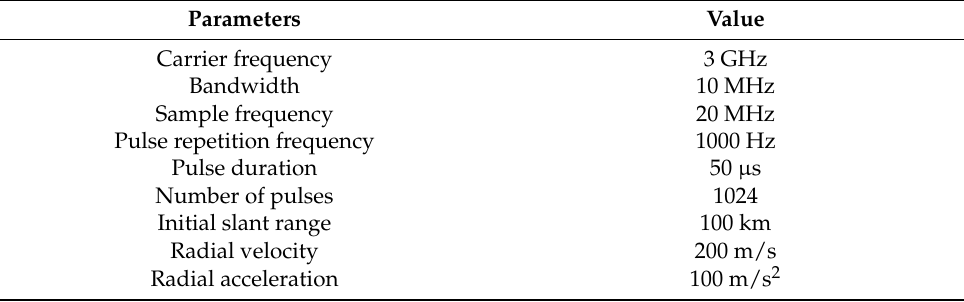
Table 3. Simulation parameters.